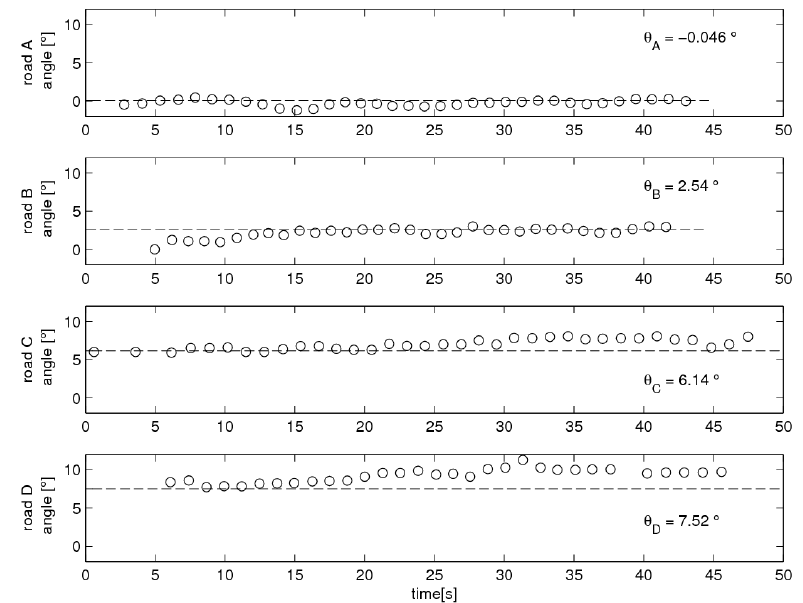
estimation for each road (the estimated value at the end of a zero velocity